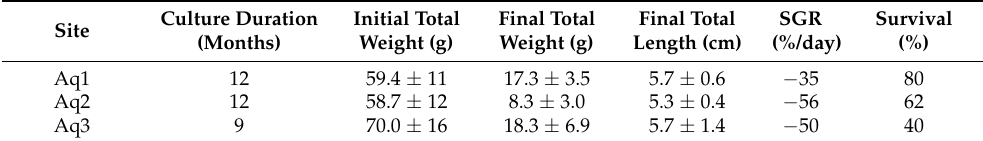
Table 4. Culture duration, initial total weight, final total weight, final total length, specific growth rate (SGR), and survival of sea cucumber (Holothuria polii) at three IMTA farms (Aq1: Epidauros, Ag2: Evoikos, Aq3: Rhodos).